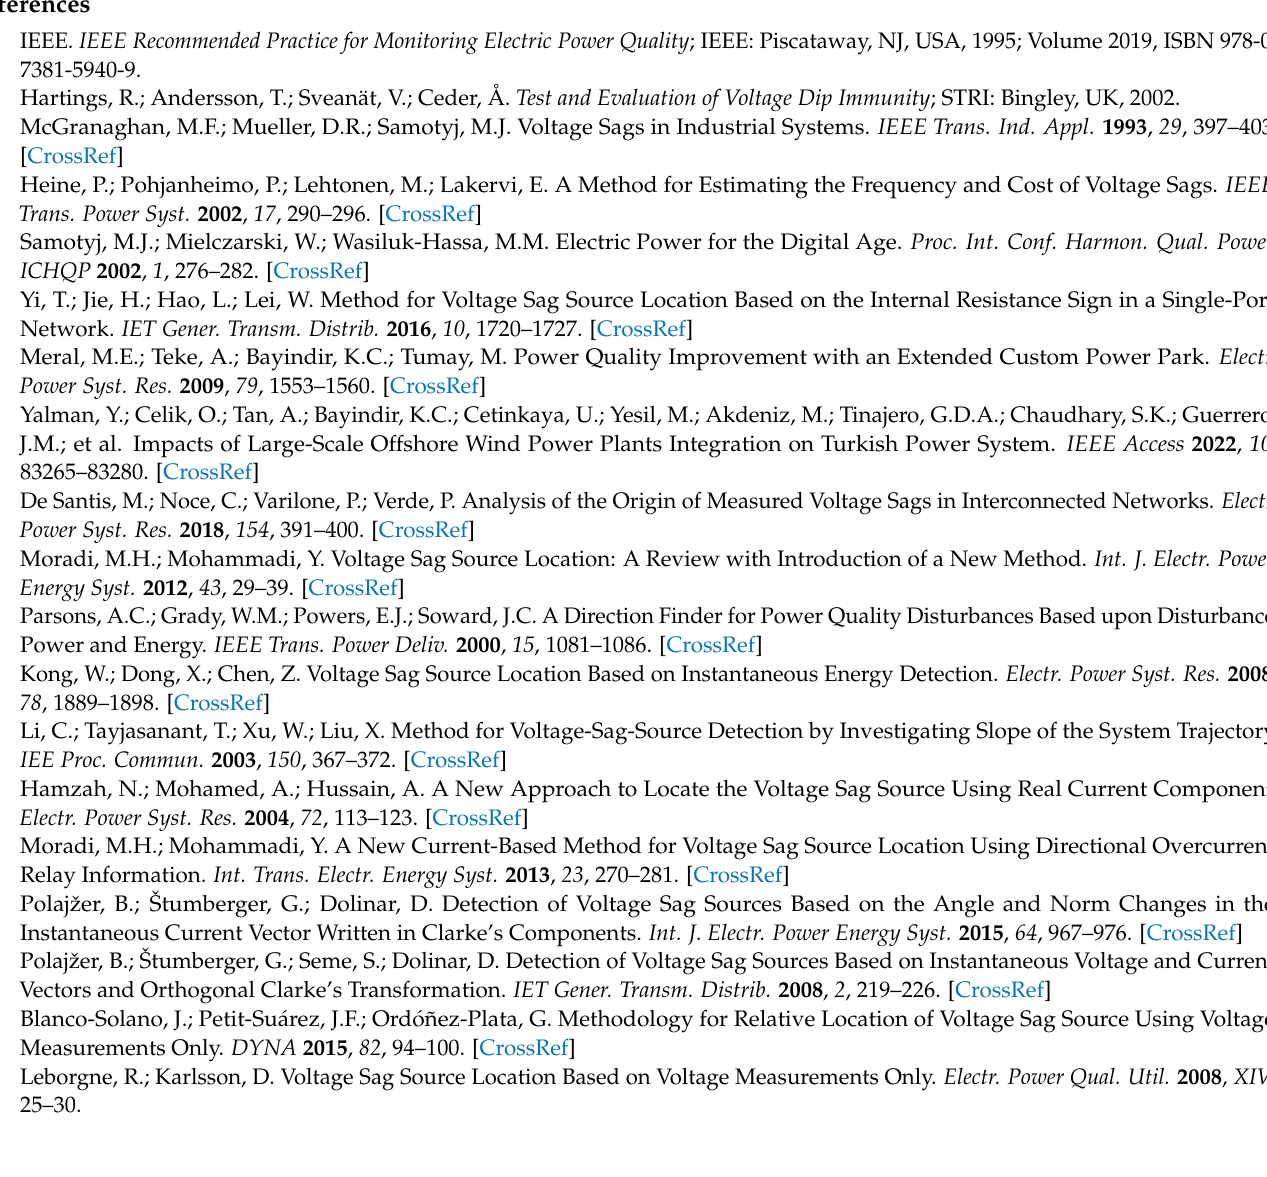
Figure A8. Current and voltage waveform recorded by PQ analyzer during the voltage sag for event 8.